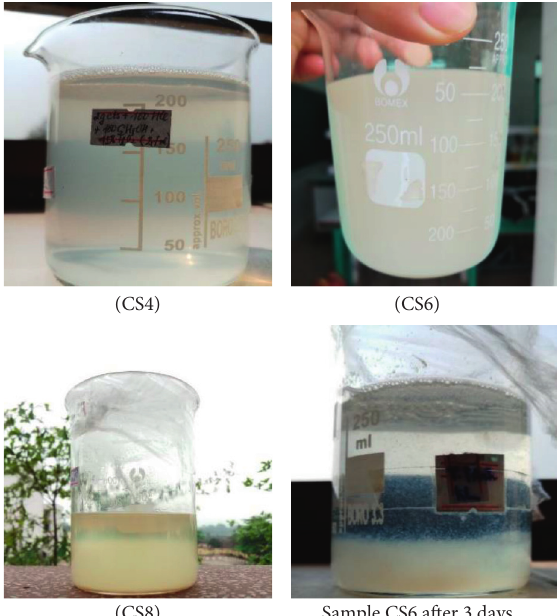
Figure 2: Oxidation of CS with H